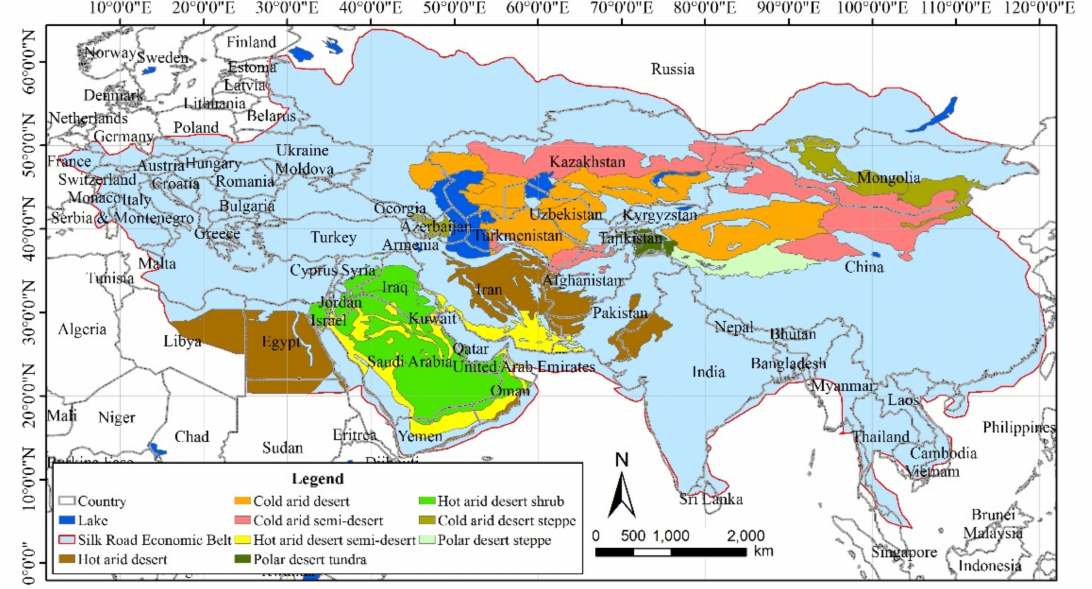
Figure 1. Location of different desert areas over the Silk Road Economic